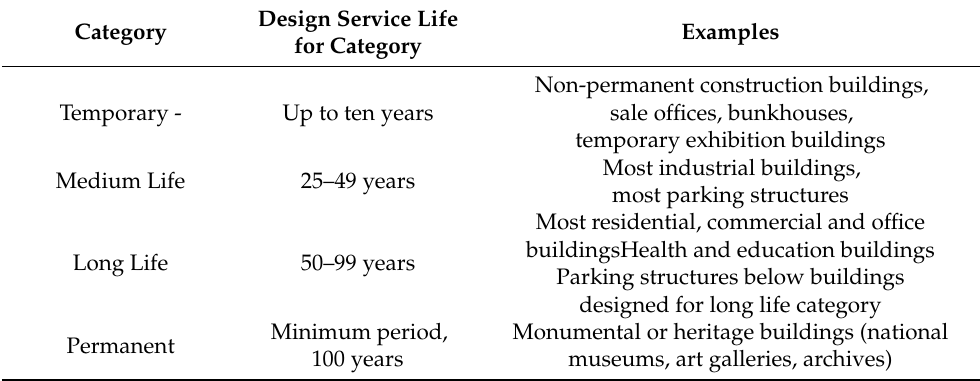
Table 2. Categories of design service lives for buildings